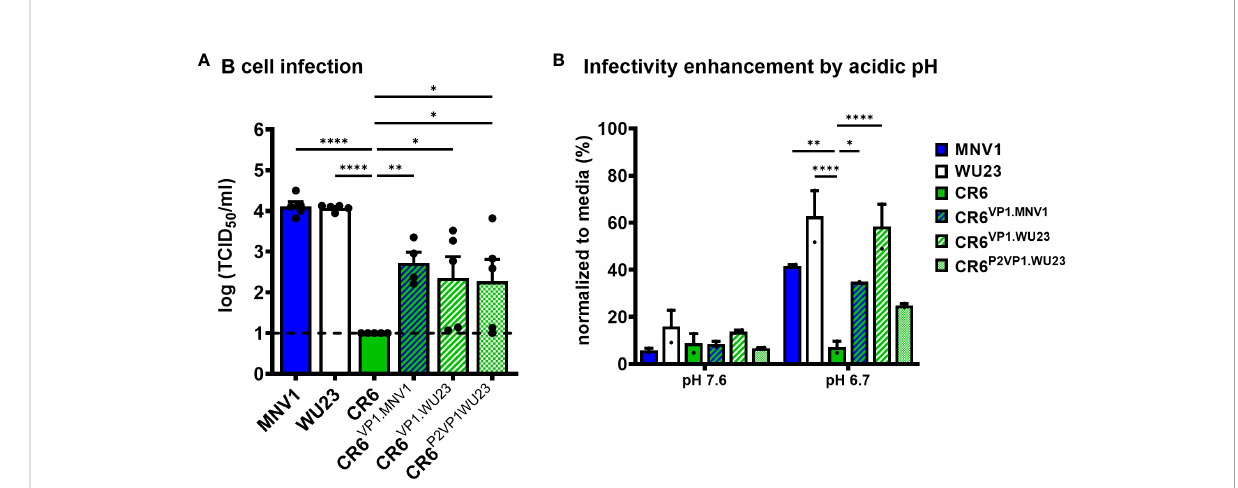
FIGURE 8 The hypervariable domain of VP1 regulates infection of CD300lf lo cells and sensitivity to environmentally triggered infectivity enhancement. (A) Duplicate wells of M12 cells were infected with MNV1, CR6, WU23, or the indicated chimeric virus at MOI 0.05. Virus titers at 1 dpi were determined by TCID 50 assay on culture supernatants. All infections were repeated four times. P values were determined using ANOVA with Dunnett ’ s multiple comparisons test using CR6 as the control group. (B) BV2 cells were infected with 100 TCID 50 units per well of MNV1, WU23, CR6, CR6 VP1.MNV1 , CR6 VP1.WU23 , or CR6 P2VP1.WU23 in neutral PBS (pH 7.6) or PBS at pH 6.7. Virus titers were determined by plaque assay and normalized to viral titers following infection in media. P values were determined using ANOVA with Dunnett ’ s multiple comparisons test using CR6 as the control group. The experiment was repeated two times. *P < 0.05, **P < 0.01, ****P < 0.0001.